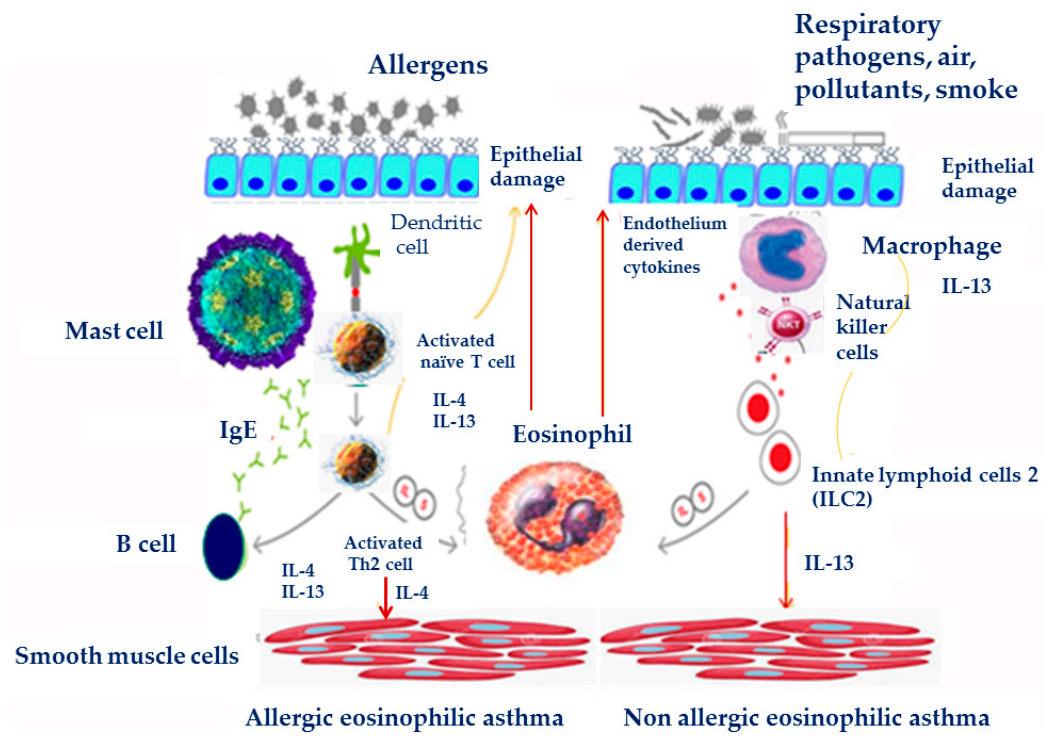
Figure 3. Pathogenesis of acute exacerbations in asthma.